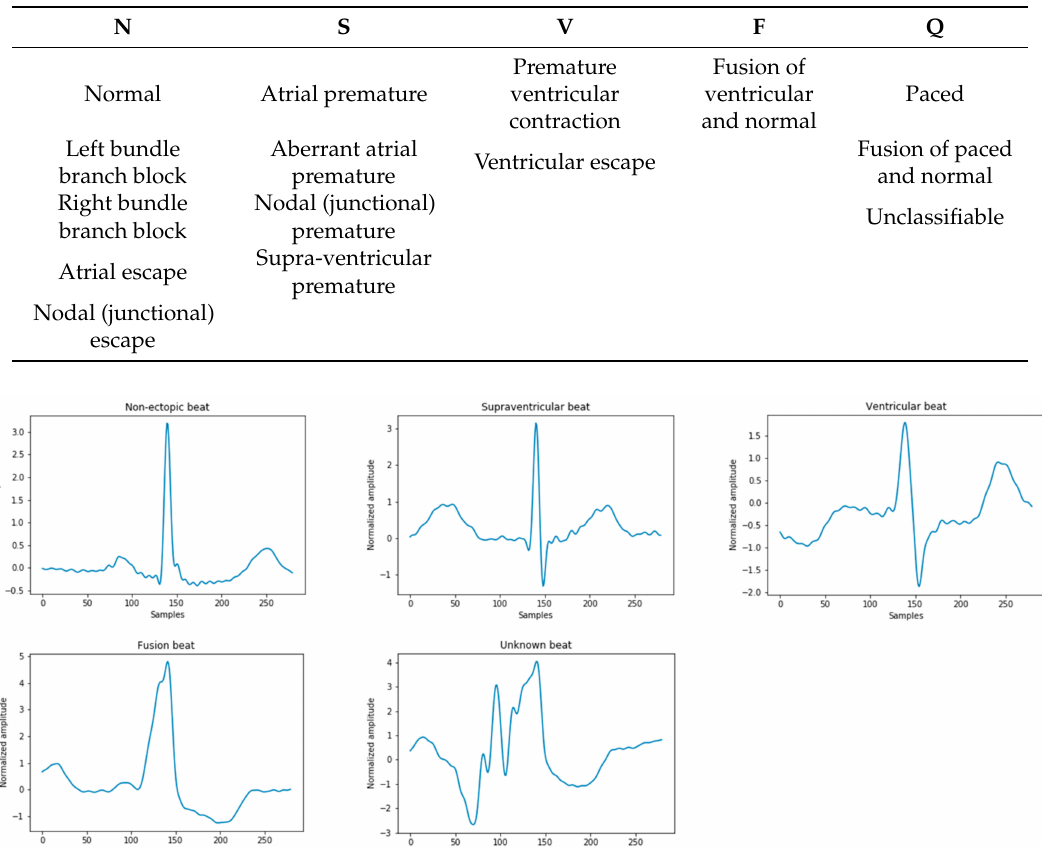
Table 1. A summary table of electrocardiogram (ECG) beats categorized as per the American National Standards Institute / Association for the Advancement of Medical Instrumentation (ANSI / AAMI EC57: 2012) standard. Normal heartbeat (N), supraventricular ectopic heartbeat (S), ventricular ectopic heartbeat (V), fusion heartbeat (F), and unknown heartbeat (Q).